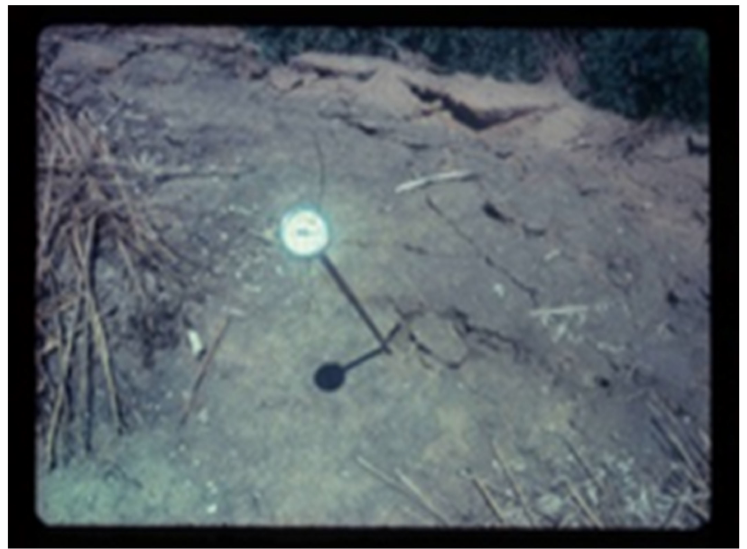
Figure 8. Peat fires at depth were a common result of the drainage of the Hula valley swamps in Israel. The temperature probe in the residual ash reveals prolonged sub-surface burning. Source: Edward